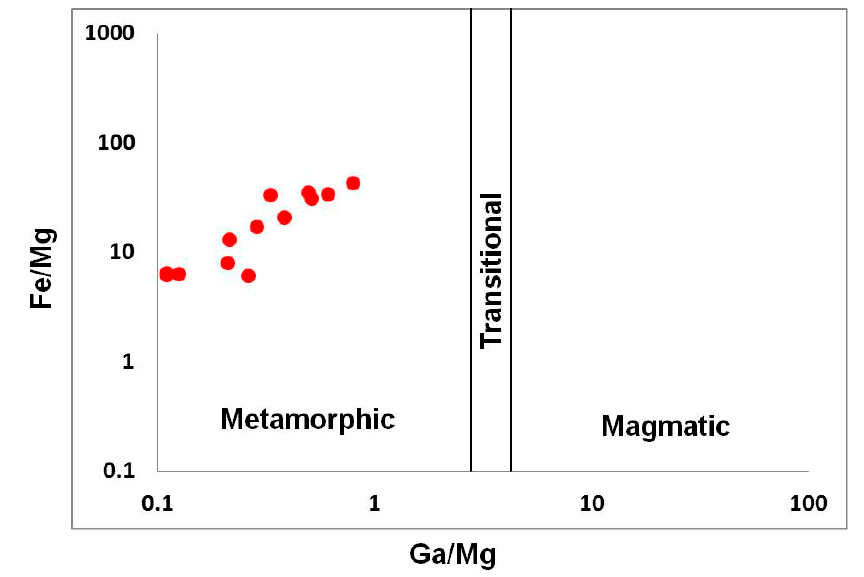
/ Mg vs. Ga / Mg discrimination diagram modified after [35,36]. Figure 8. Fe/Mg vs. Ga/Mg discrimination diagram modified after [35,36]. Figure 8. Fe